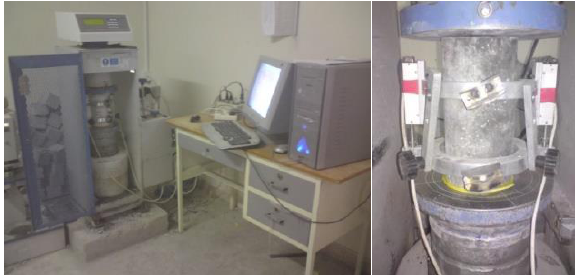
Figure 3. Compressive strength stress-strain tests apparatus.